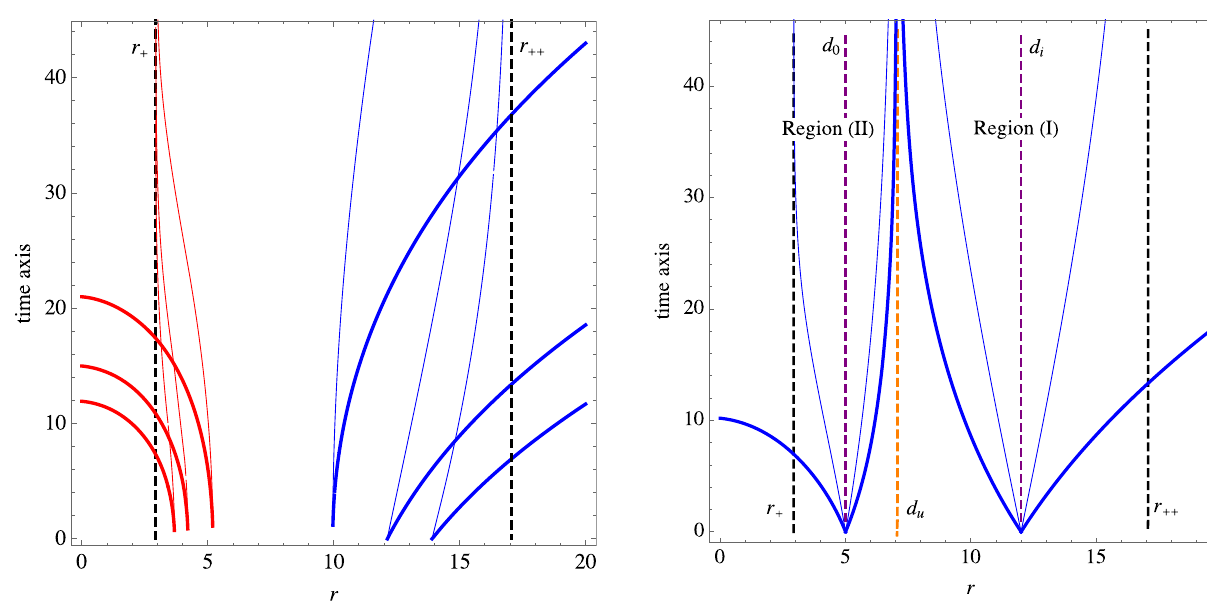
Fig. 5 The critical radial motion in regions (I) and (II), plotted for comoving (thickcurves) anddistant(thincurves)observers, forthecase of γ = 0 . 04. This value provides d u = 7 . 07 corresponding to E 2 u = 0 .